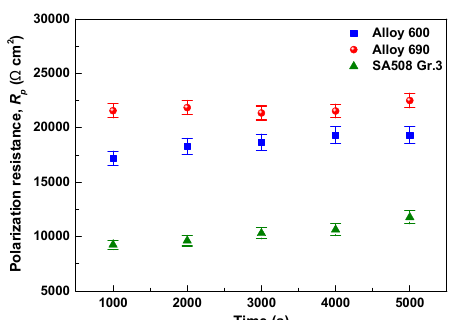
Figure 8. Polarization resistances of the SG materials calculated during linear polarization test in